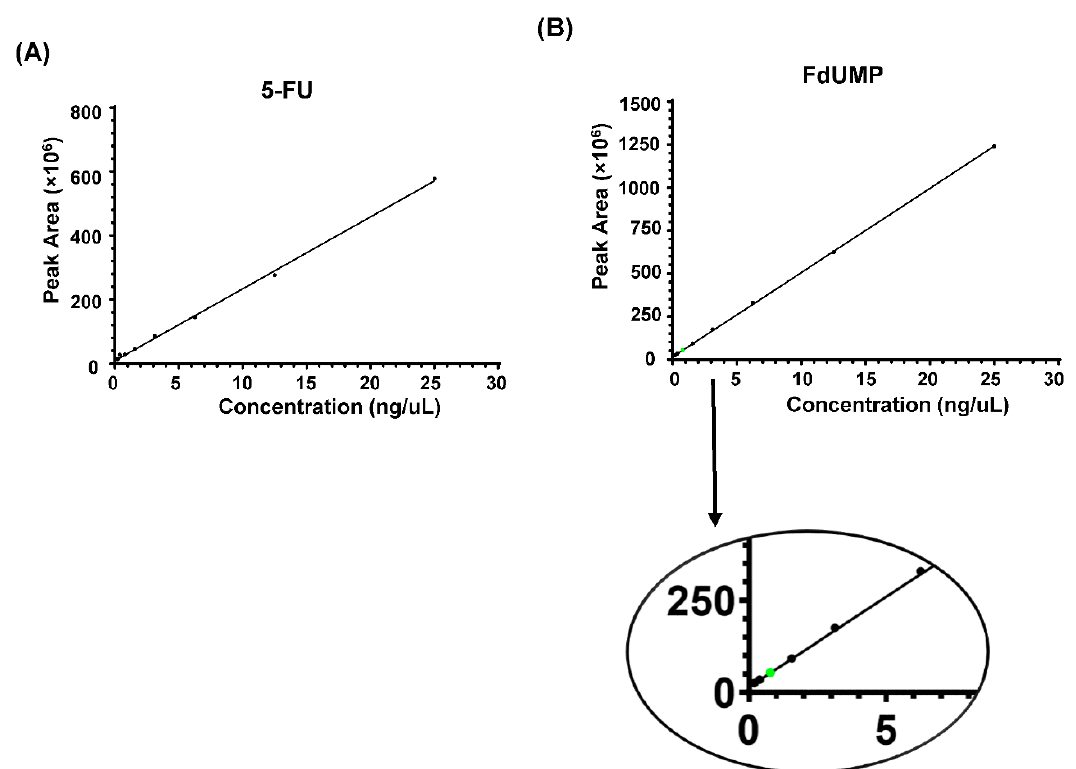
Figure 2. Generation of 5-FU and FdUMP calibration curve. Lowest limit of detection and quantification are two key factors for the accurate results. To determine the limits of detection and for the relative comparison of the results, the calibration curve was generated using the peak area obtained from serially diluted 5-FU ( A ) and FdUMP ( B ) spiked into conditioned media from the parental cell culture. The green dot from the curve represents the peak area of the 0.780 ng / µ L concentration of FdUMP, which was selected for the relative comparison of the detected compounds.